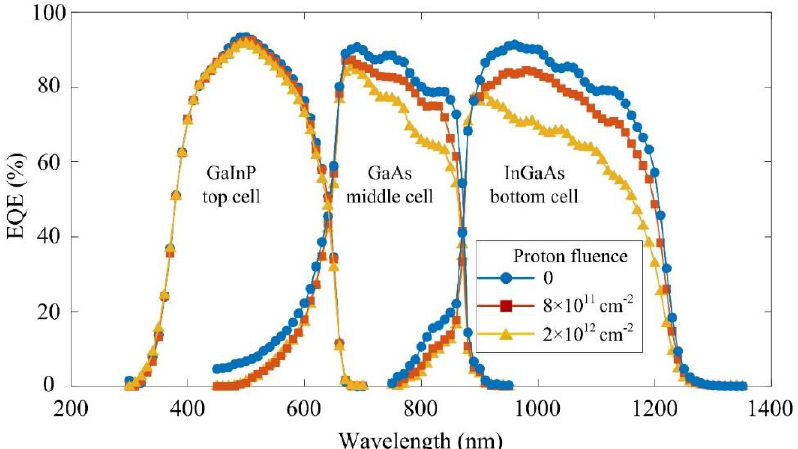
Figure 5. EQE measurements were performed on an IMM3J solar cell before and after proton irra- diation.